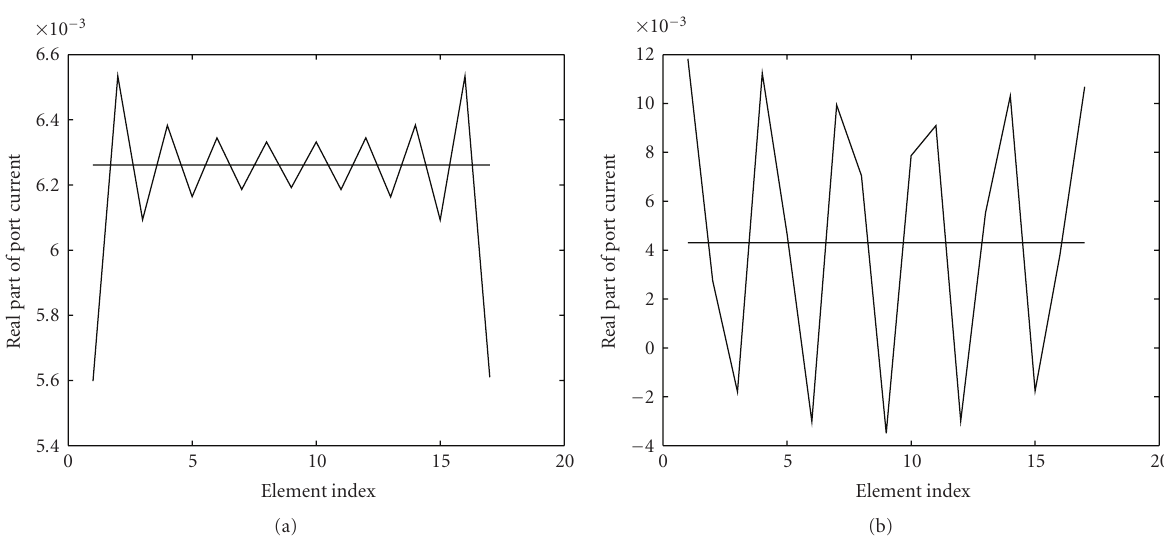
Figure 3: Real part of port currents in array of 17 dipoles excited in phase. Horizontal lines: infinite-array simulations. (a) without eigenmodes; (b) with eigenmodes.